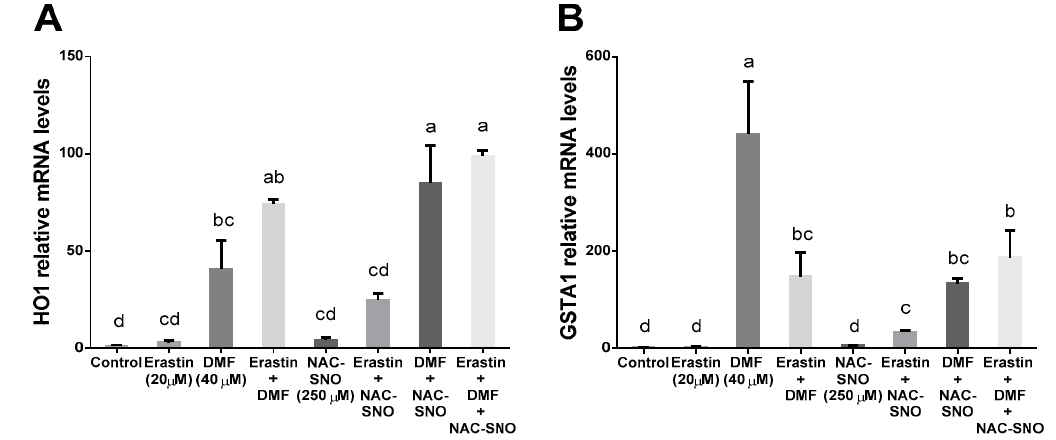
Figure 7. The effect of DMF on Nrf2 activation in ferroptosis. Nrf2-related genes expression ( A , B ) in AML12 hepatocytes treated with 20 µ M erastin, 40 µ M DMF, and 250 µ M NAC-SNO for 6 h. Means with different letters are statistically different ( p < 0.05).